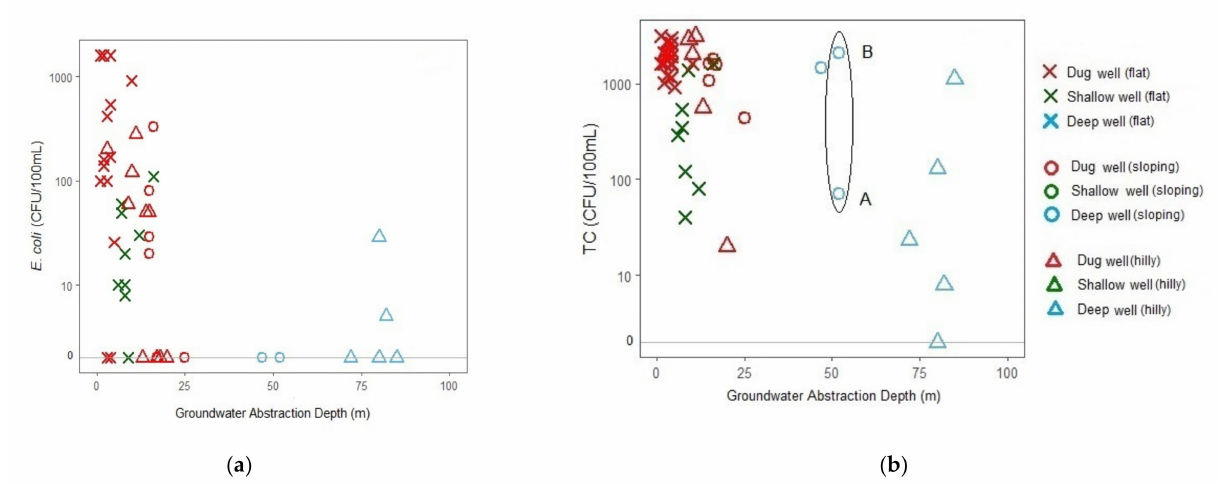
Figure 9. ( a ) E. coli and ( b ) TC concentration in water samples with different groundwater abstraction depths and well types. Water samples represented as A and B were collected from the same deep well but different